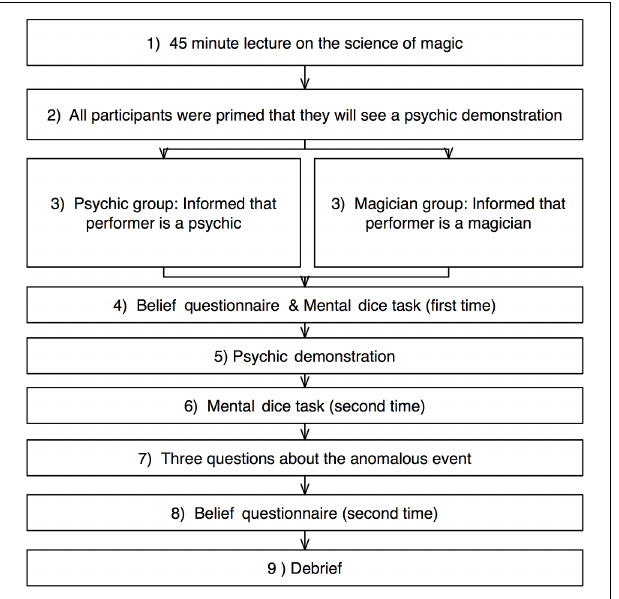
FIGURE 1 | Schematic demonstration of the sequence of events for participants in the magician and in the psychic